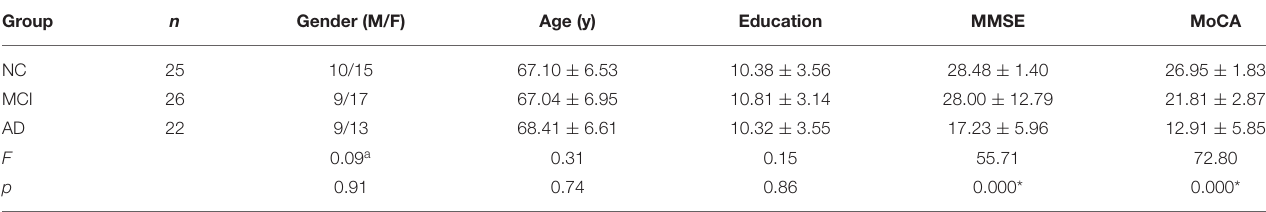
TABLE 2 | Demographic information and neurocognitive